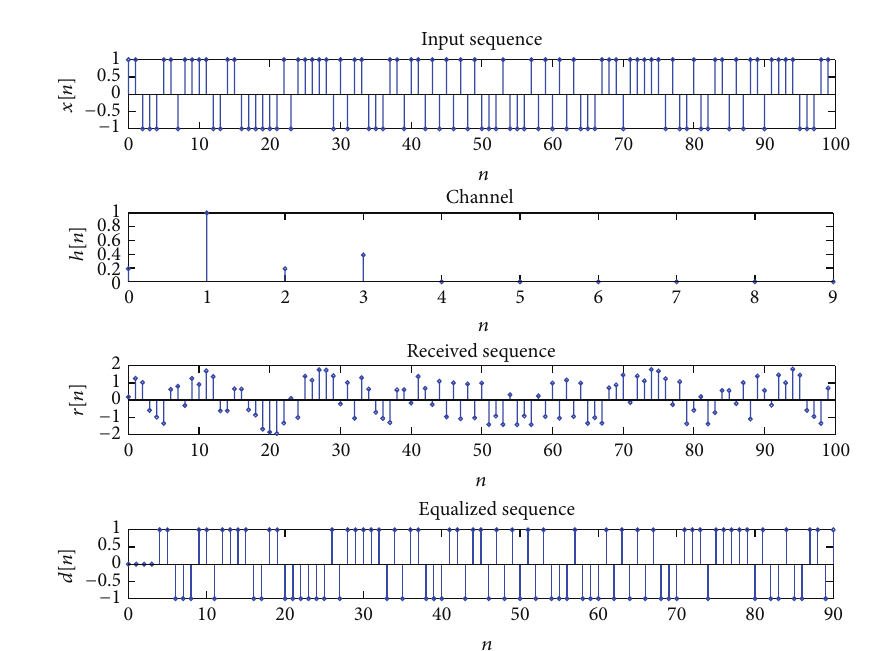
Figure 6: Performance results of an QRD-RLS adaptive equalizer for a 4 -tap